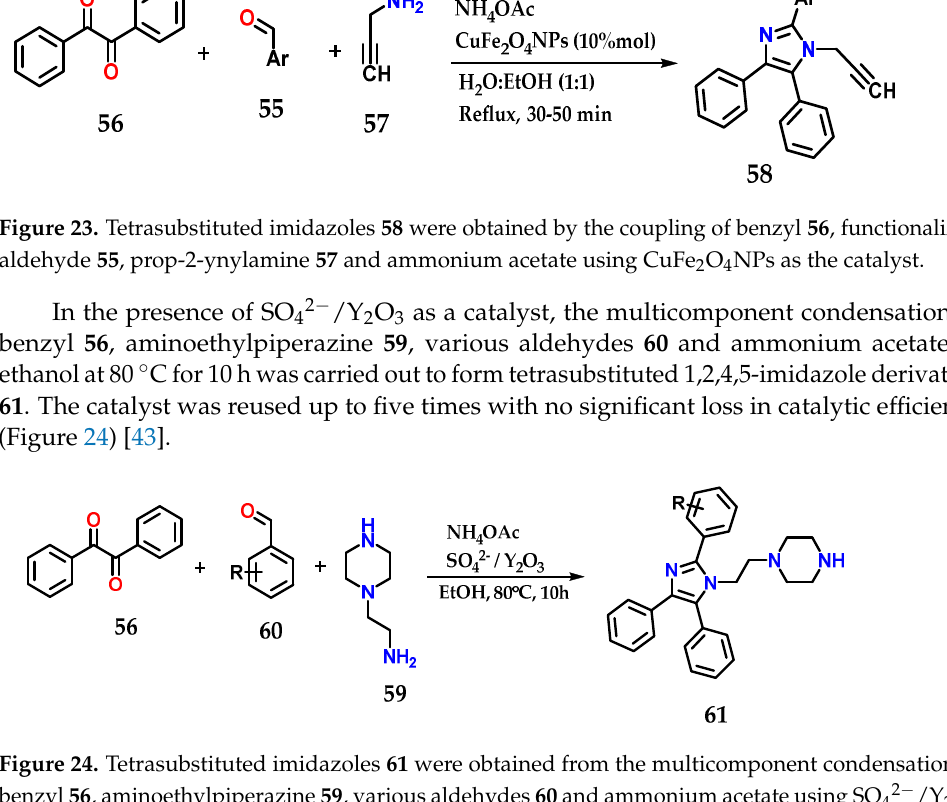
Figure 22. Obtaining benzo[ d ]imidazo[2,1- b ]thiazoles 51 from the condensation of aromatic ketones 52 and 5-(biphenyl-4-yl)-1,3,4-thiadiazol-2-amine 53 .